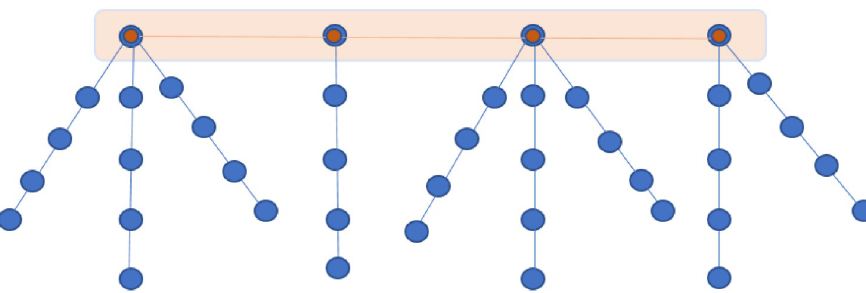
Fig 1. Graph G representing a bi-modal integrated network with the path graph (train network) in orange and the forest (bus network) in blue.